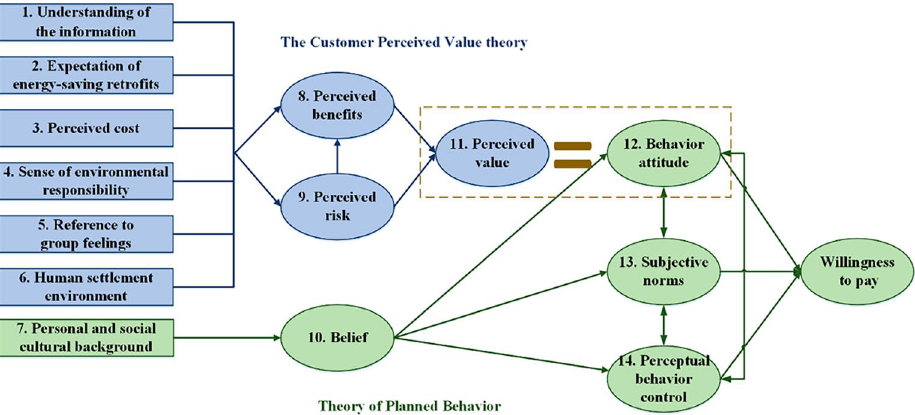
Figure 1. Decision-making model of resident WTP for energy-saving retrofits of residential